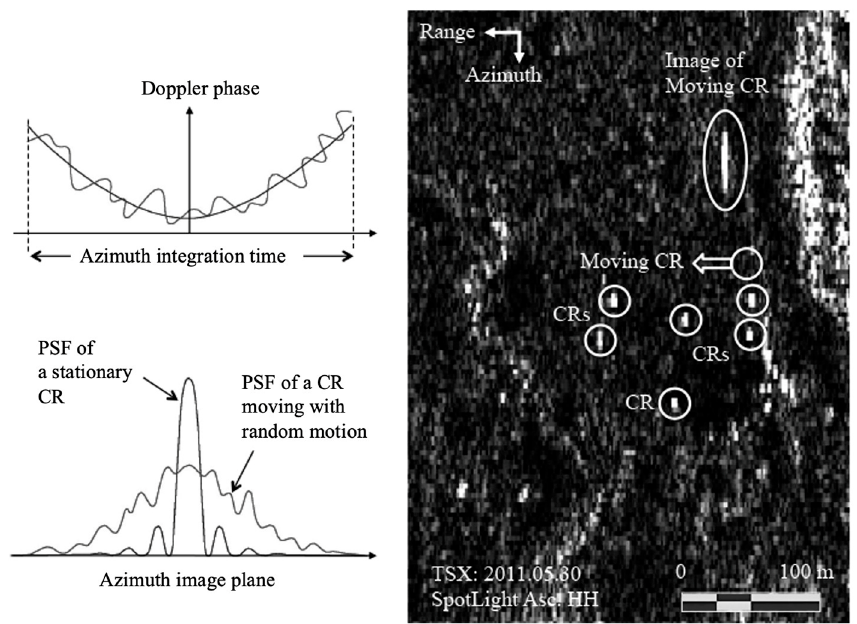
Figure 6 . RADARSAT–2 X–band SAR image of Chuuk Lagoon, Micronesia, showing the bright az- imuth streaks caused by breaking waves along the coastal barrier.